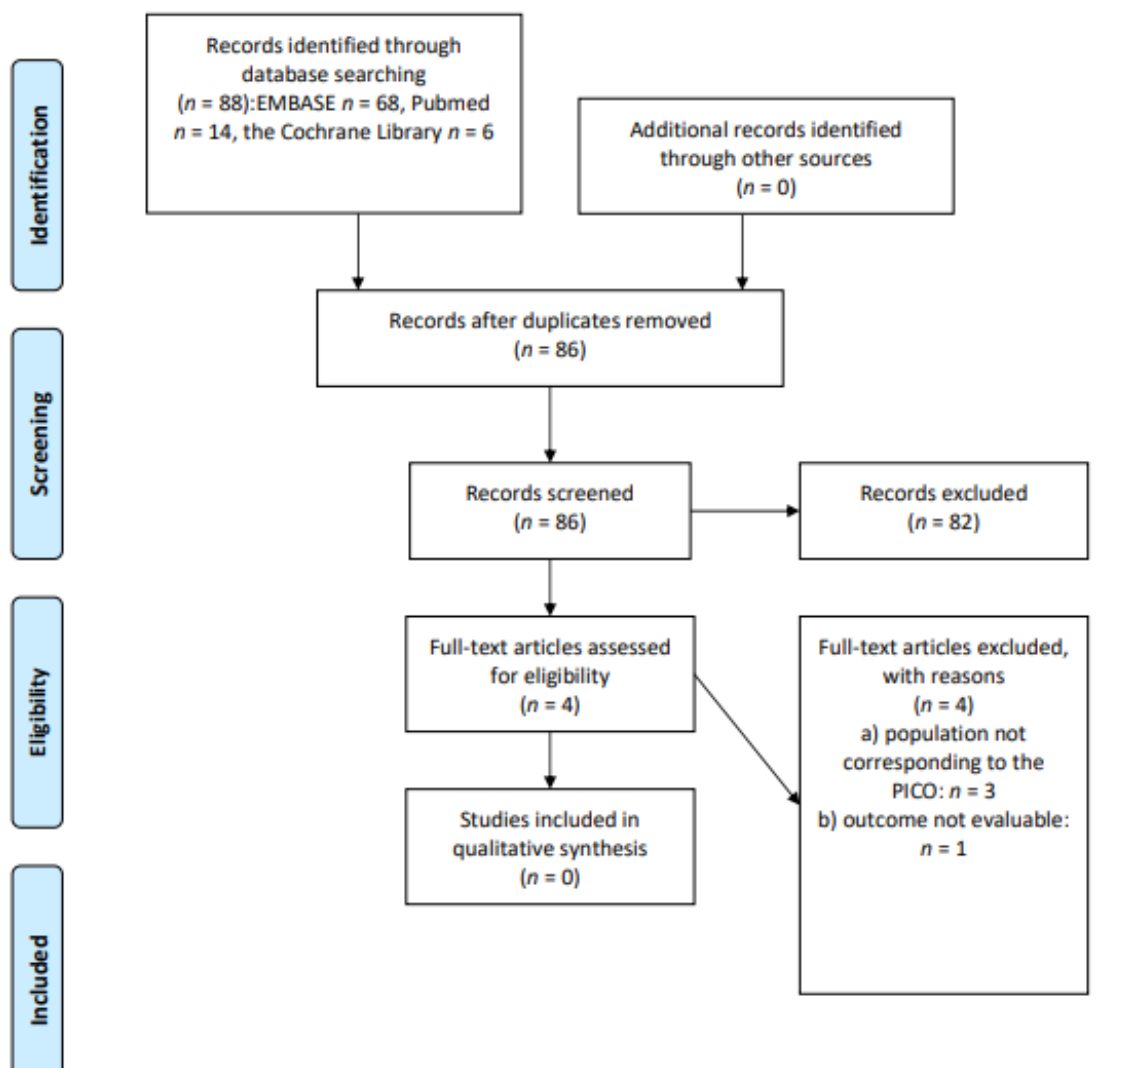
Figure 2. PRISMA flow-chart on Mediterranean diet/nutritional intervention.